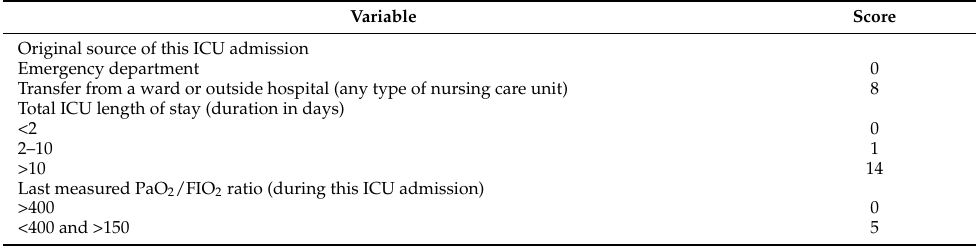
Table A1. Stability and Work Load Index for